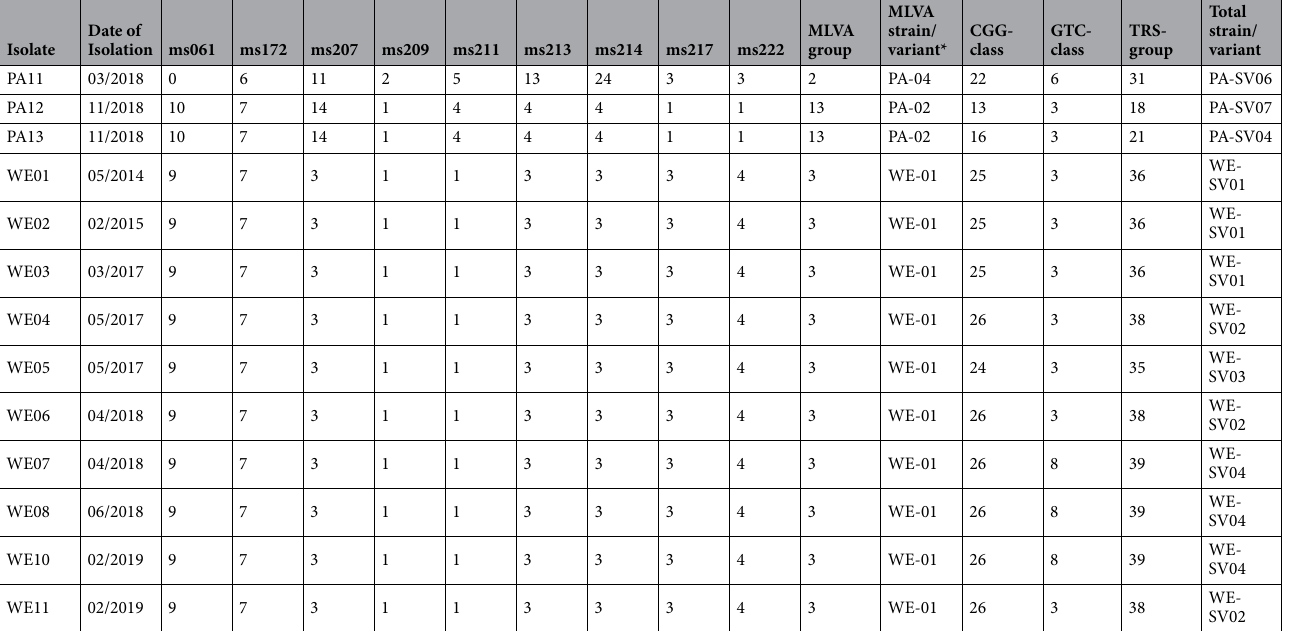
Table 1. The comparison of MLVA and TRS-PCR genotyping results for 63 P. aeruginosa isolates from 8 CF patients. Isolate—single colony obtained from the selective agar plates of plated sputum samples from